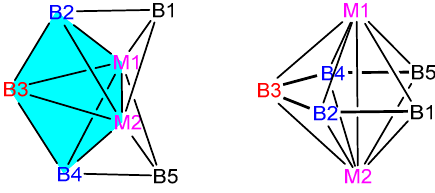
Figure 2. Two different views of the cluster cage of M 2 B 5 clusters of type I. Table 1. Skeletal electron pair (sep), selected structural parameters and 11 B chemical shifts of 1 – 8. Metallaborane